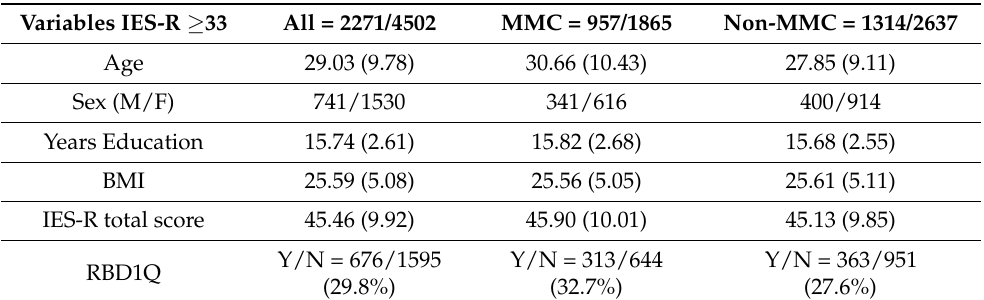
Table 4. Demographics for participants with IES-R scores of ≥ 33. n = 2271, all; n = 957, MMC; n = 1314 non-MMC subjects. Data in Mean